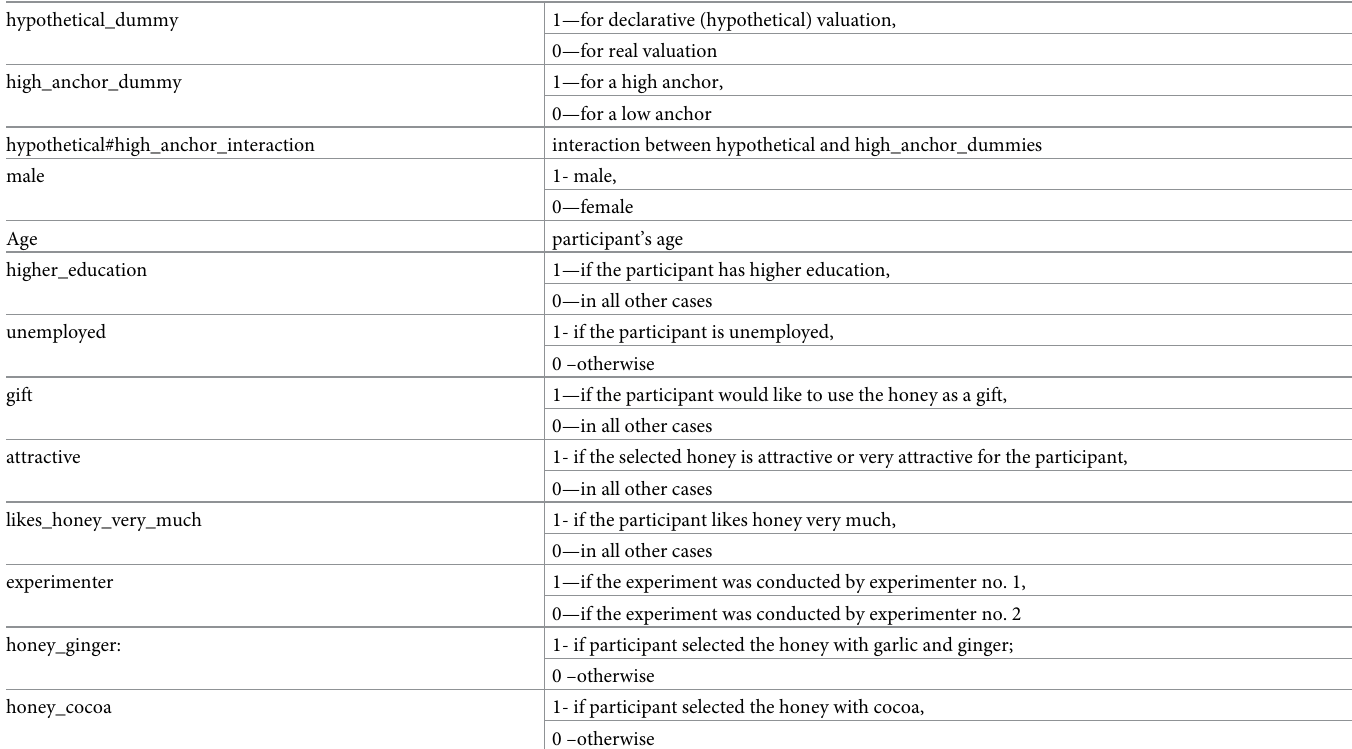
Table 13. Experiment 3: Variable